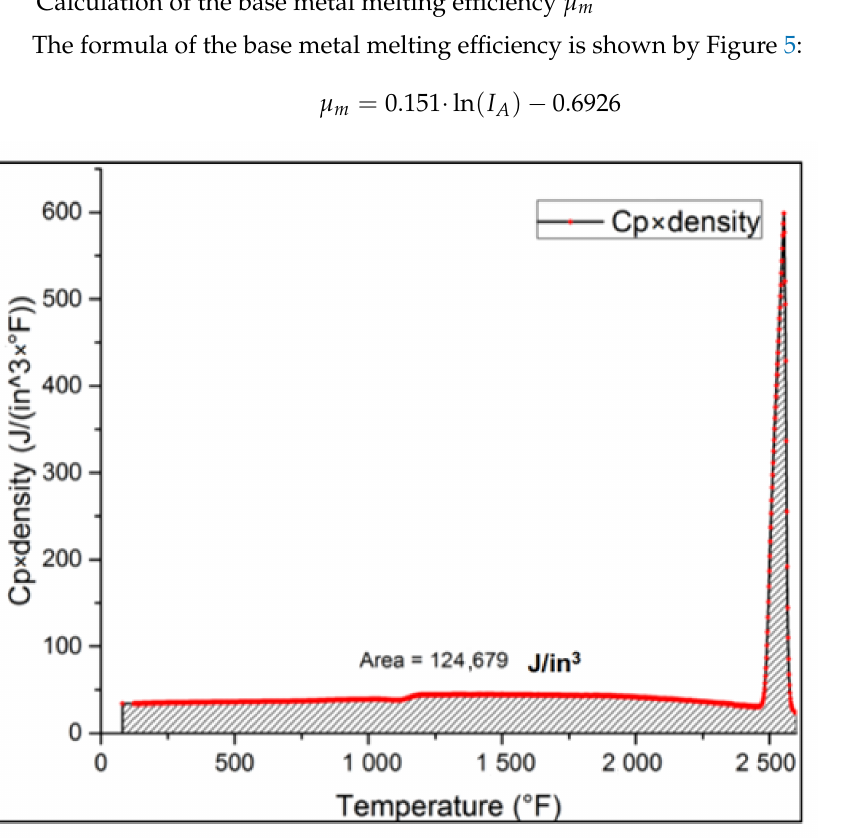
Figure 5. Heat energy required for the melting unit volume